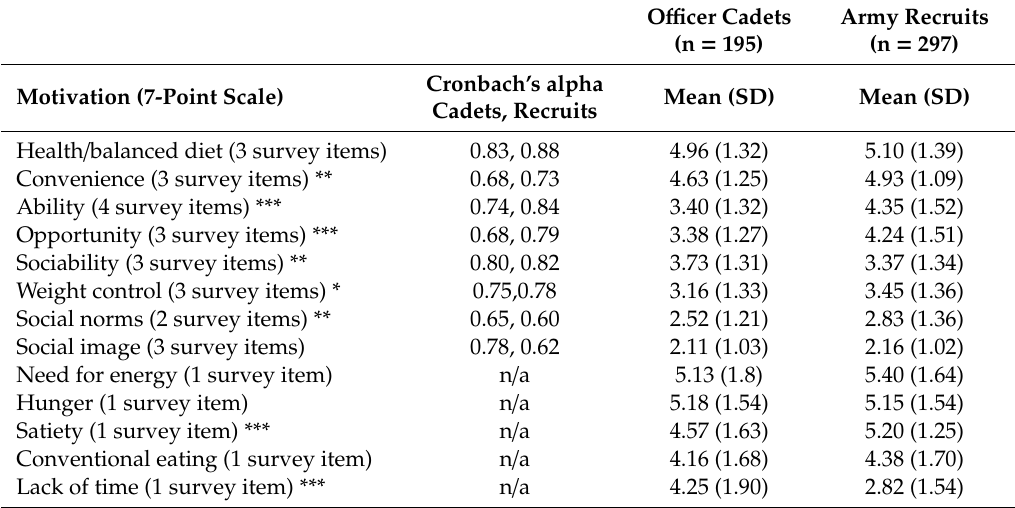
Table 3. Constructs a ff ecting motivations for